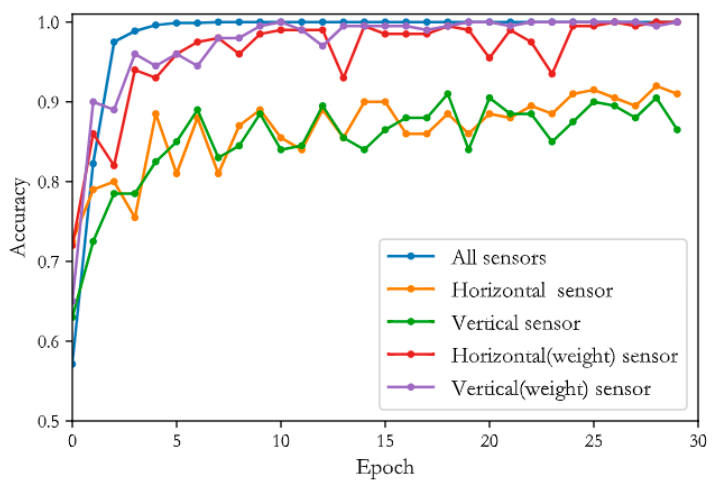
Figure 14. Comparison of recognition accuracy between the different types input.